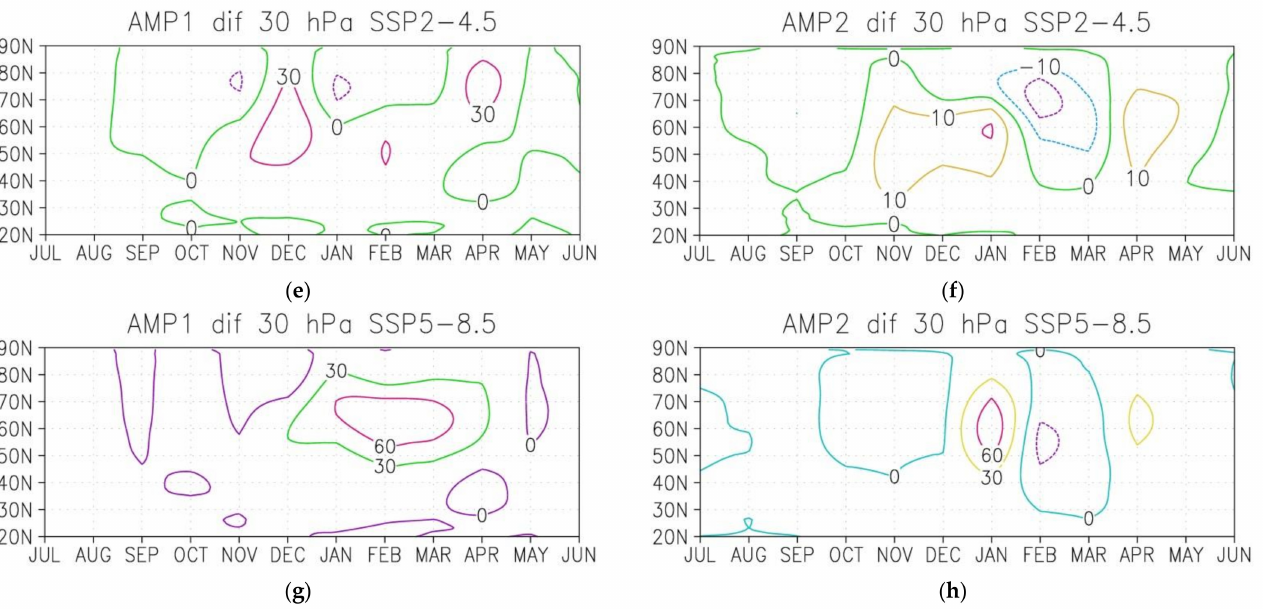
Figure 3. Difference of planetary wave number 1 and 2 amplitude (gpm) averaged over December– February between periods 2081–2100 and 2016–2035 in moderate ( a , b ) and severe scenario ( c , d ). The same but for the seasonal cycle of wave number 1 and 2 at pressure level 30 hPa ( e – h